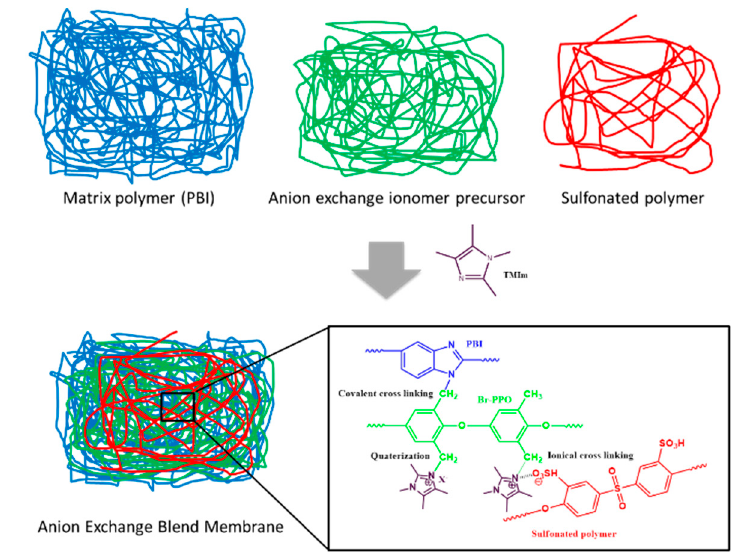
Figure 2. A diagrammatic depiction of the preparation of the anion-exchange blend membranes.